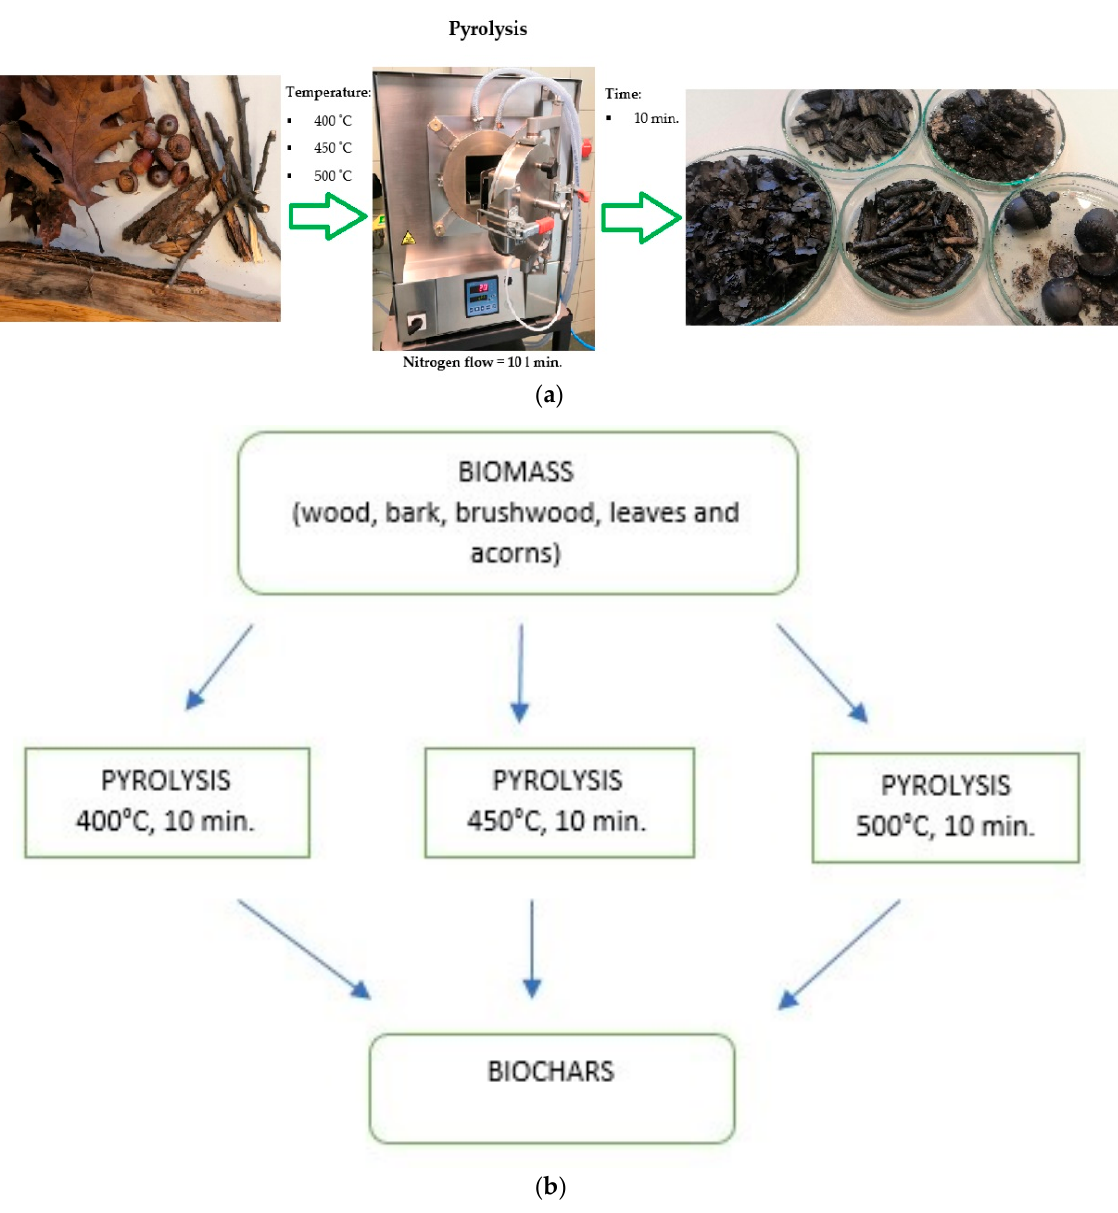
Figure 1. Scheme of the samples preparation process ( a ), flow chart of the experiment operation ( b ).